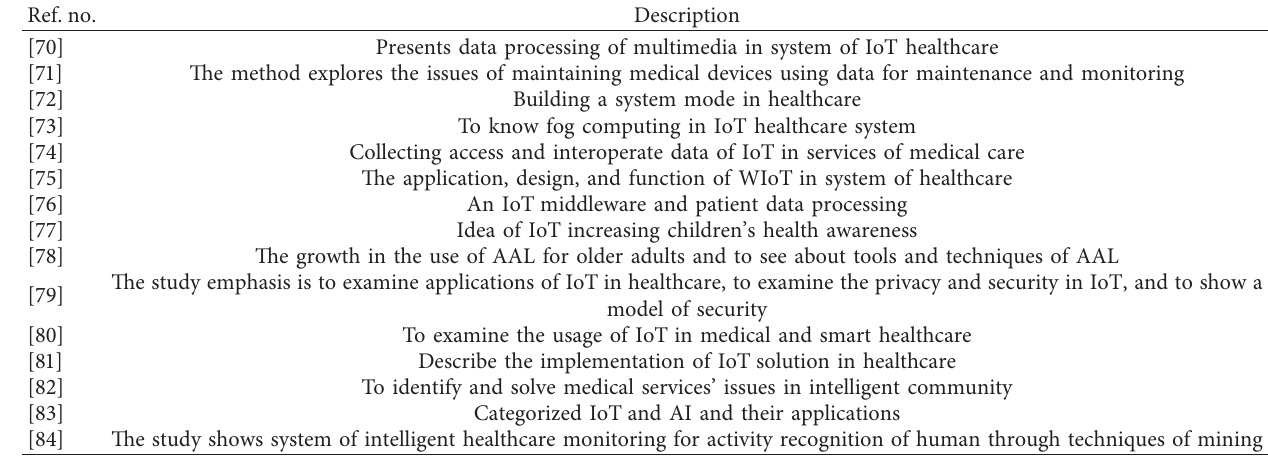
Table 2: Literature related to AI and IoT.